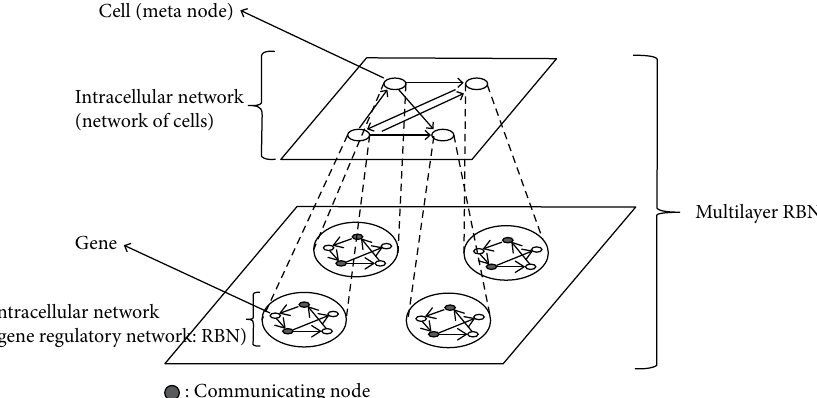
Figure 1: A schematic diagram of a multilayer RBN model. In actual simulations, the number of nodes of an intercellular network was 9, and the number of nodes of an intracellular network was